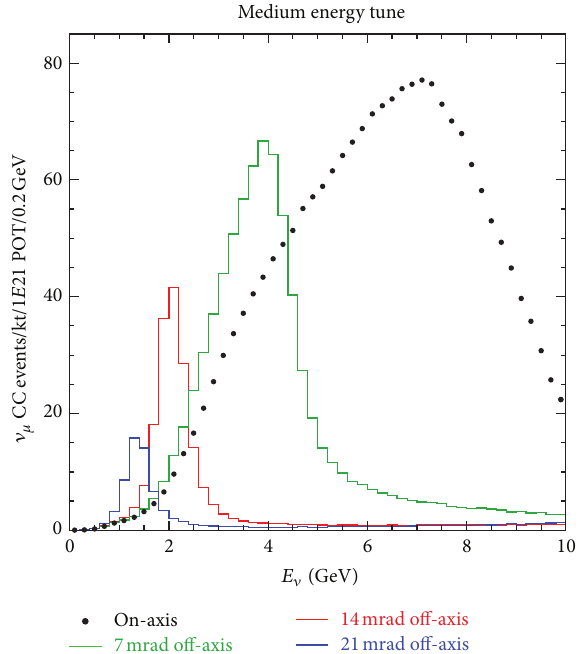
Figure 5: The simulated NuMI energy spectrum as it will be in the NO 𝜈 A-era with the beamline in the “medium energy” configuration. The NO 𝜈 A detectors will sit 14mrad off-axis and the energy spectrum at that angle is shown by the red histogram. In contrast, the MINOS+ experiment will sit on-axis and so collect thousands of neutrino interactions per year that will be measured with an 𝐿/𝐸 resolution at the 10% level: the on-axis spectrum is shown by the black dots. The green and blue histograms further illustrate how the spectrum changes with the off-axis